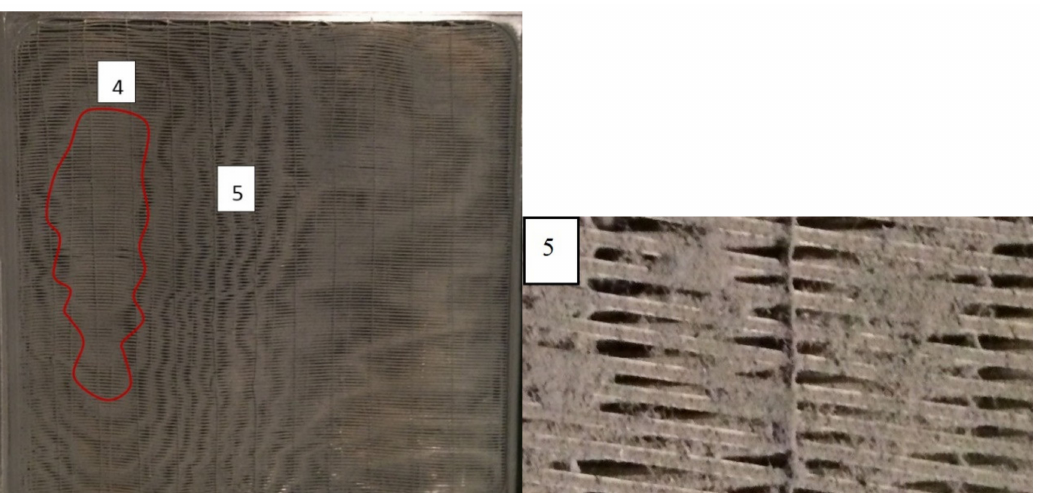
Figure 6. Heat exchanger surface after injection of 1200 g m − 2 of test dust ( left ). The majority of the front surface of fibers is covered with the deposit layer. There are zones where the deposit blocks the gap between the fibers (as in zone 4) or creates the lines of the blocked zones (as in zone 5, see details ( right )).